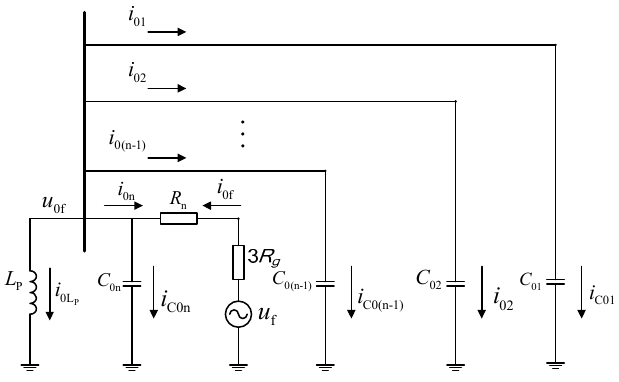
Figure 2. Zero ‐ sequence current circuit in SPG fault. Figure 2. Zero-sequence current circuit in SPG